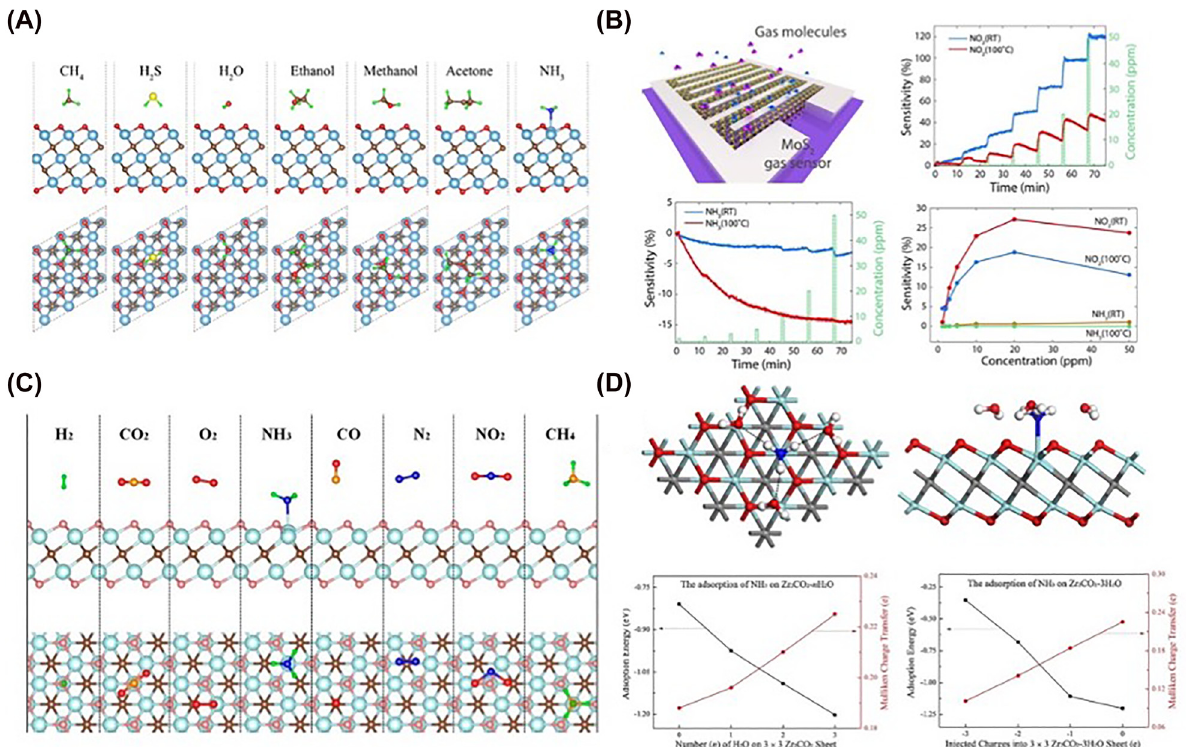
C MXene based gas sensor for NH 3 2 and NH . (C) Porous DPSNs@X% TiO -X composite photocatalyst was used for the detection 2 3 2 sensors or capture. Figures are adapted from references 3